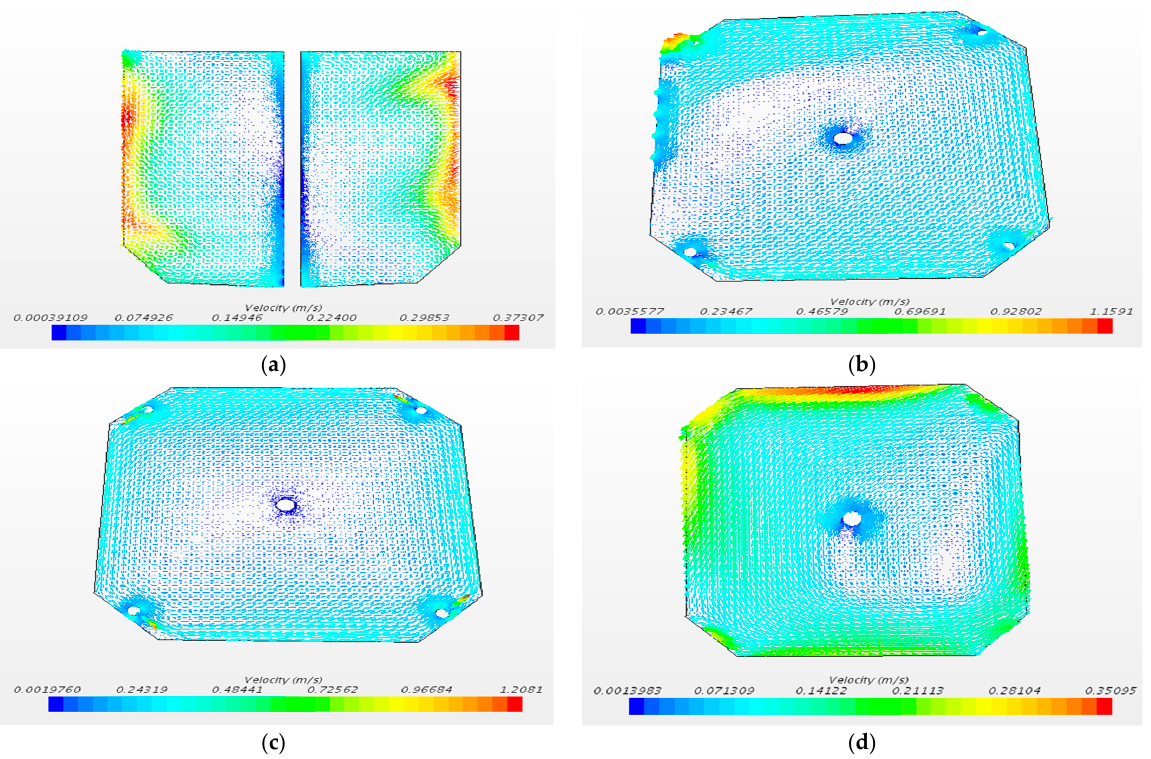
Figure 10. ( a ) middle longitudinal section, ( b ) H = 16.5 m cross section, ( c ) H = 8.5 m cross section, ( d ) H = 1.5 m cross section.